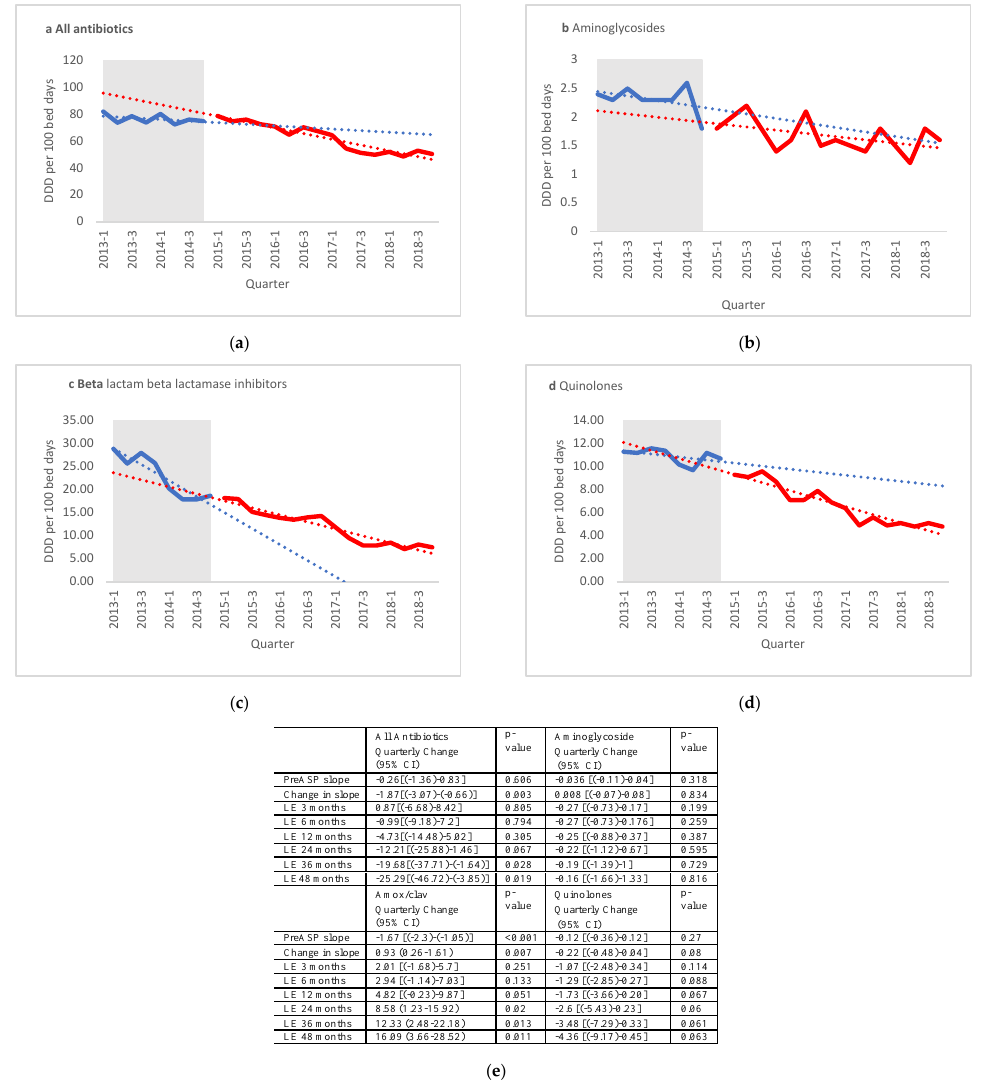
Figure 1. Interrupted time series analysis for quarterly defined daily doses (DDD)/100 bed days. ( a ) All antibiotics, ( b ) aminoglycosides, ( c ) beta lactam beta lactamase inhibitors, ( d ) quinolones. Shaded areas present pre-antibiotics stewardship intervention period. ( e ) LE — Level effect, PreASP — Pre-antibiotic stewardship intervention, Amox/clav — Amoxicillin clavulanate.